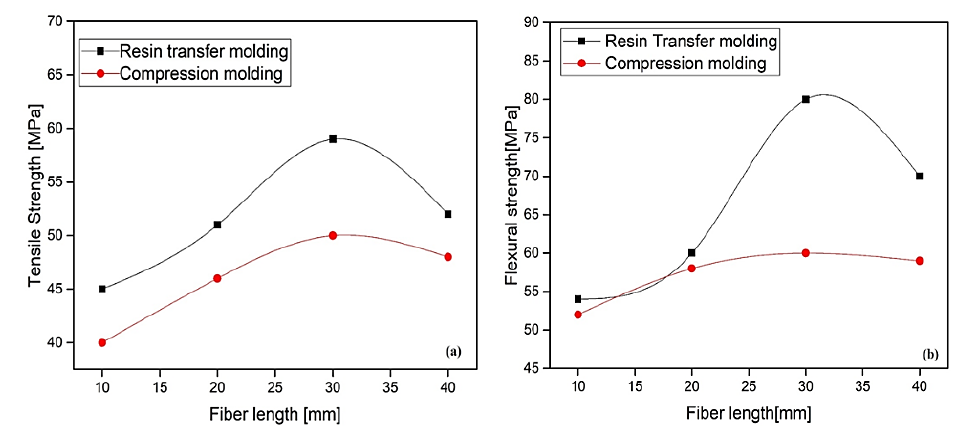
Figure 9. ( a ) Tensile strength, and ( b ) Flexural strength at different lengths (10, 20, 30, and 40 mm) at 30 vol. % of sisal/polyester composites. Adapted with permission from Reference [78]. Copyright 2009, with permission from Elsevier.